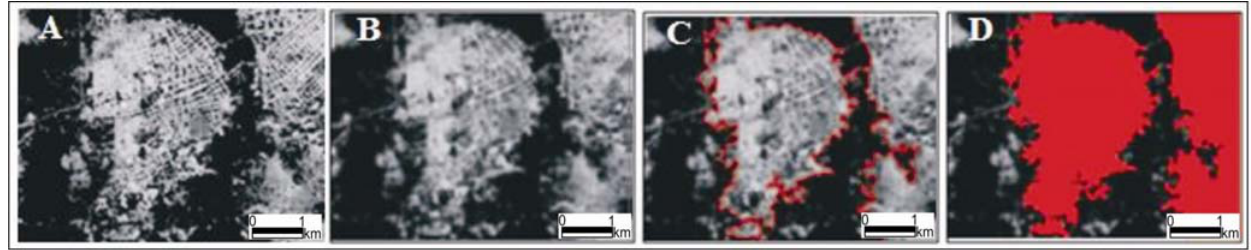
Figure 2. Digital image processing steps used to identify spatial units of human occupation in the west Santarém region in the example below: ( A ) the TM5-TM4 subtraction image, ( B ) the image after 3 × 3 average filtering, ( C ) limits from the segmented image and ( D ) image